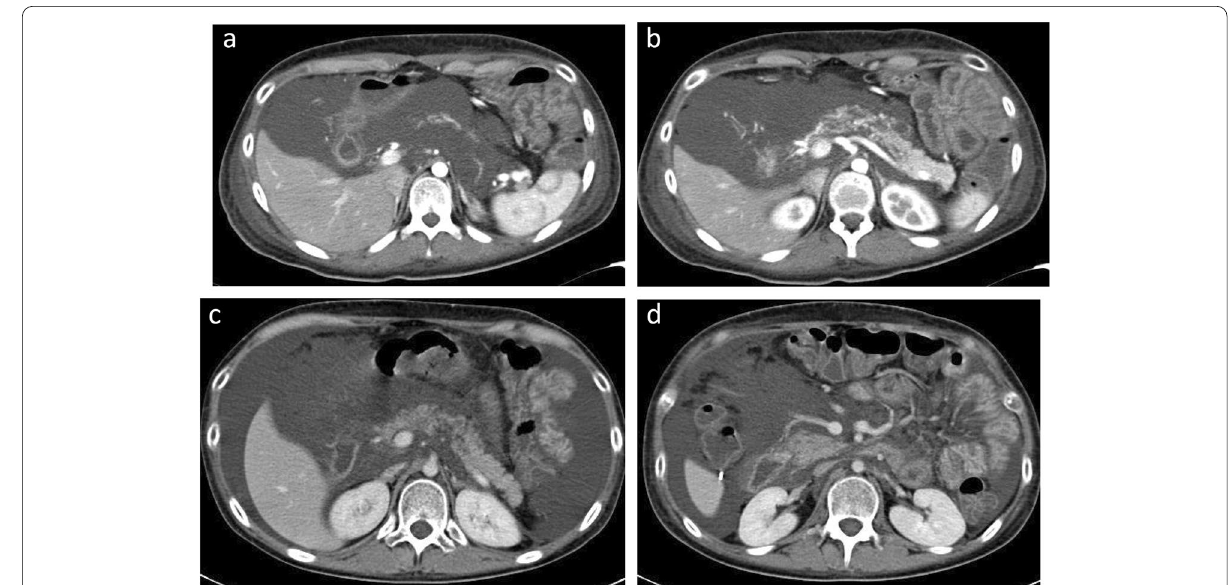
Fig. 1 Enhanced CT findings of case 7. Case 7 enhanced CT finding with chylous ascites with PLGE. a , b CT findings before intralesional sclerotherapy using OK-432. c , d CT findings after intralesional sclerotherapy using